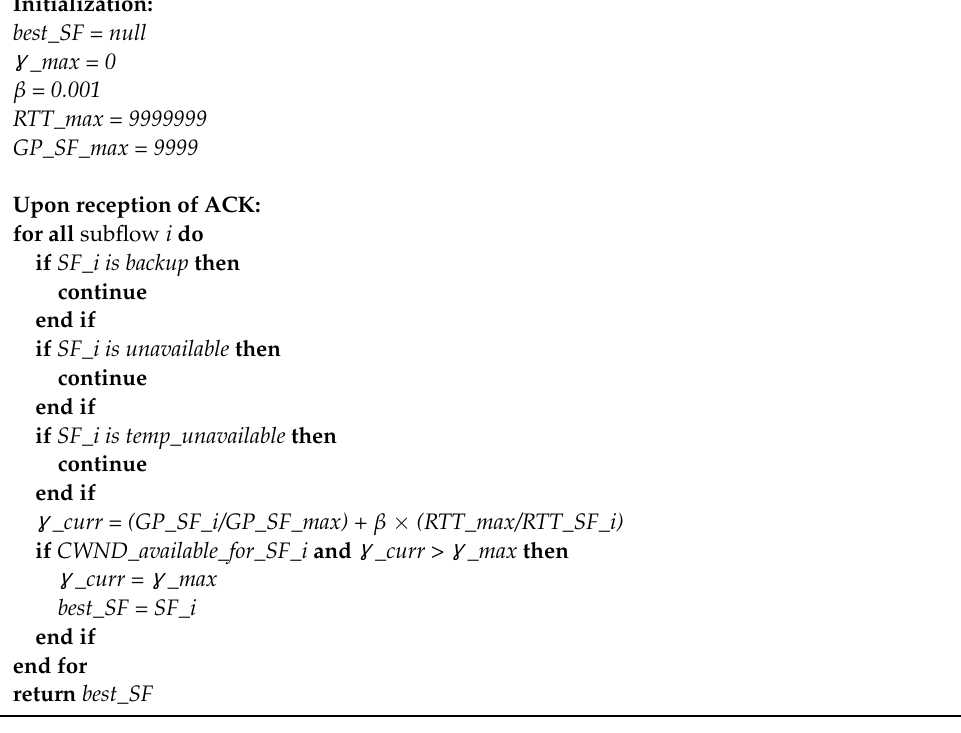
Algorithm 1: Low latency and high data rate (LLHD) Scheduling algorithm